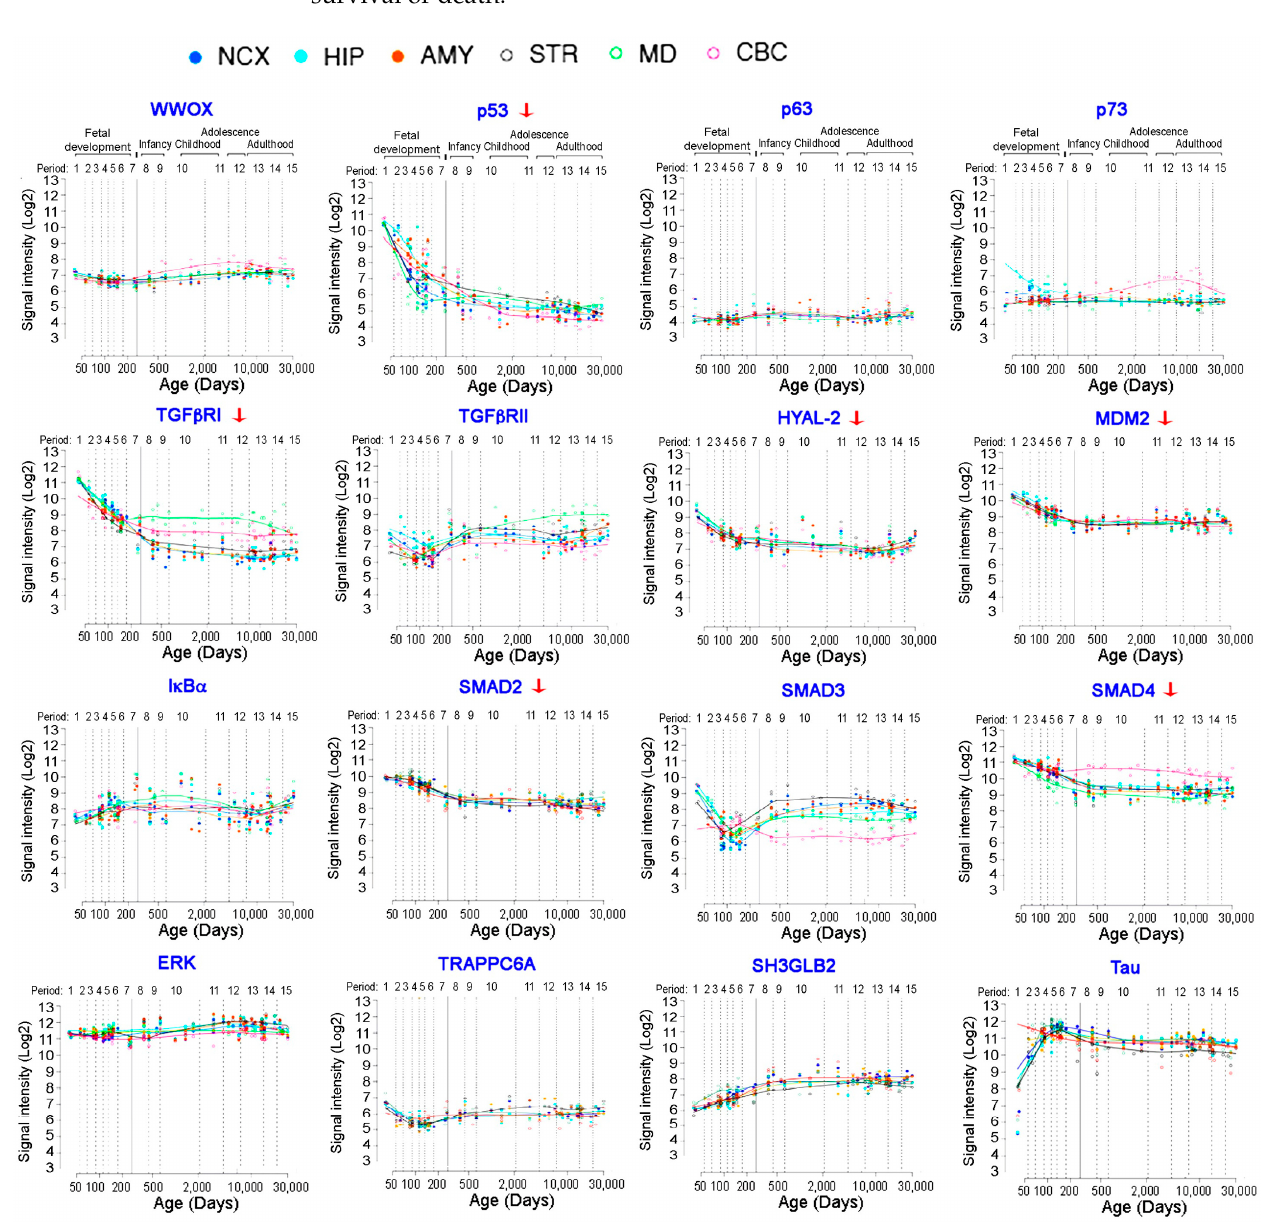
Figure 2. Selected gene expression profiles in the brain with age. Six gene-encoded proteins, including p53, TGF β RI, Hyal-2, MDM2, Smad2 and Smad4, are known to participate in growth suppression and apoptosis. Notably, their gene expression tend to downregulate with age. The gene expression data are from the database of the Human Brain Transcriptome (https://hbatlas.org/pages/hbtd) [85,86]. Gene expression is shown from the brain areas, including cerebellar cortex (CBC), mediodorsal nucleus of the thalamus (MD), striatum (STR), amygdala (AMY), hippocampus (HIP), and 11 areas of neocortex (NCX). Certain genes are not downregulated with age, and their encoded proteins participate in the I κ B α /WWOX/ERK [54] and WWOX/TGF β RII signal pathways [47]. However, proapoptotic proteins, including p53, Hyal-2, Smad4, and WWOX, tend to undergo downregulation with